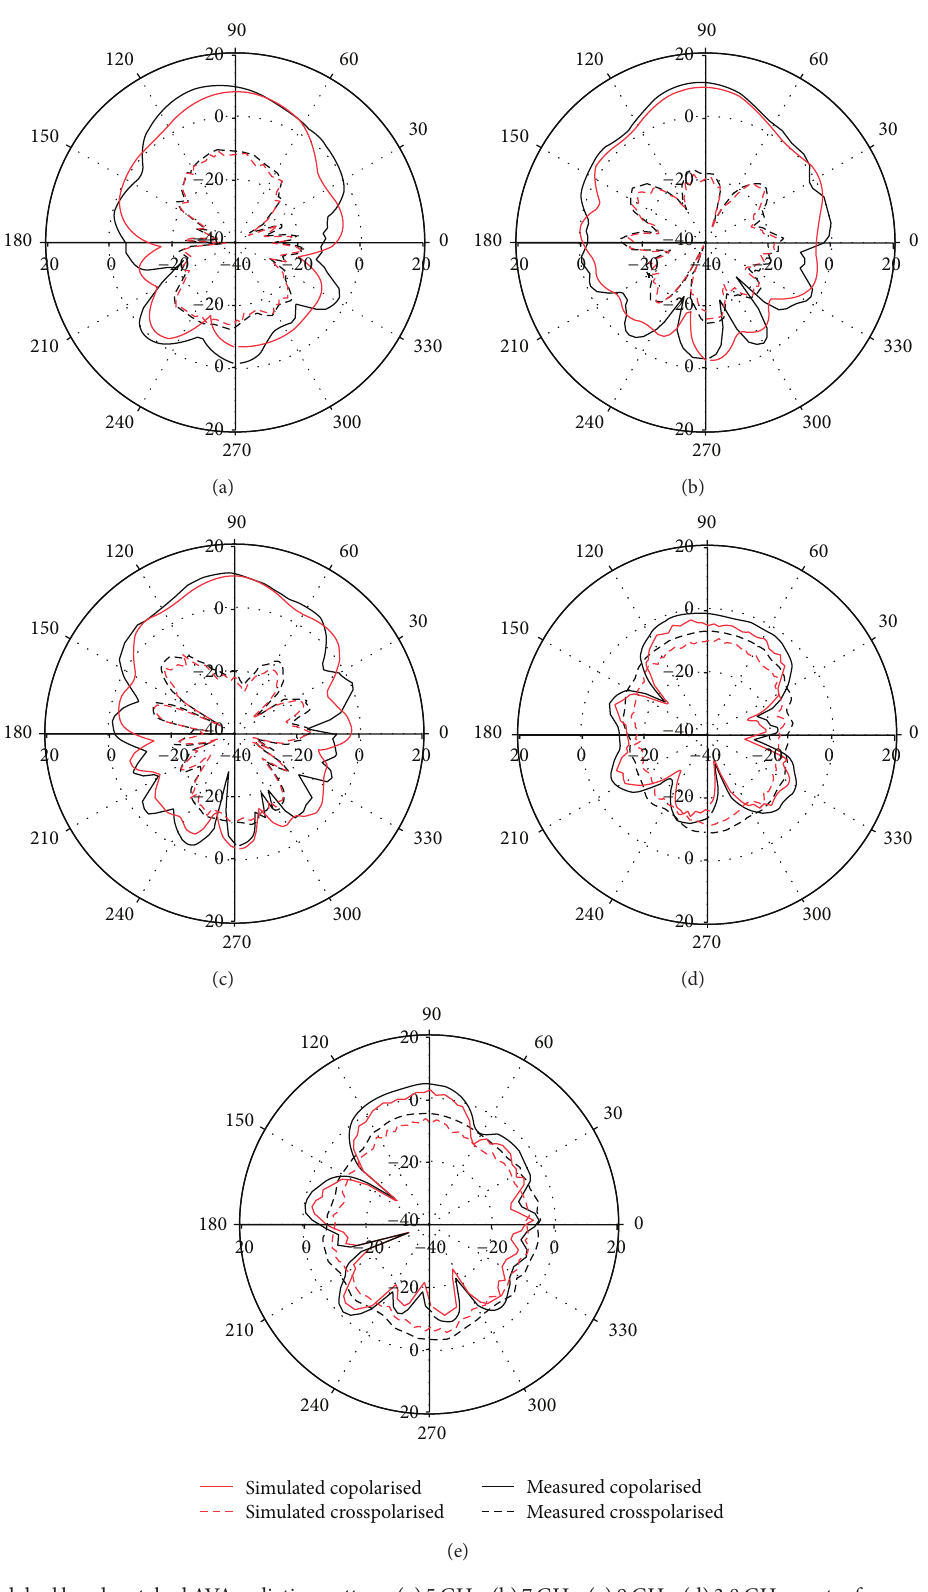
Figure 9: Proposed dual band-notched AVA radiation pattern: (a) 5 GHz, (b) 7GHz, (c) 9GHz, (d) 3.8 GHz, center frequency of the 1st notch, and (e) 5.7 GHz, center frequency of the 2nd